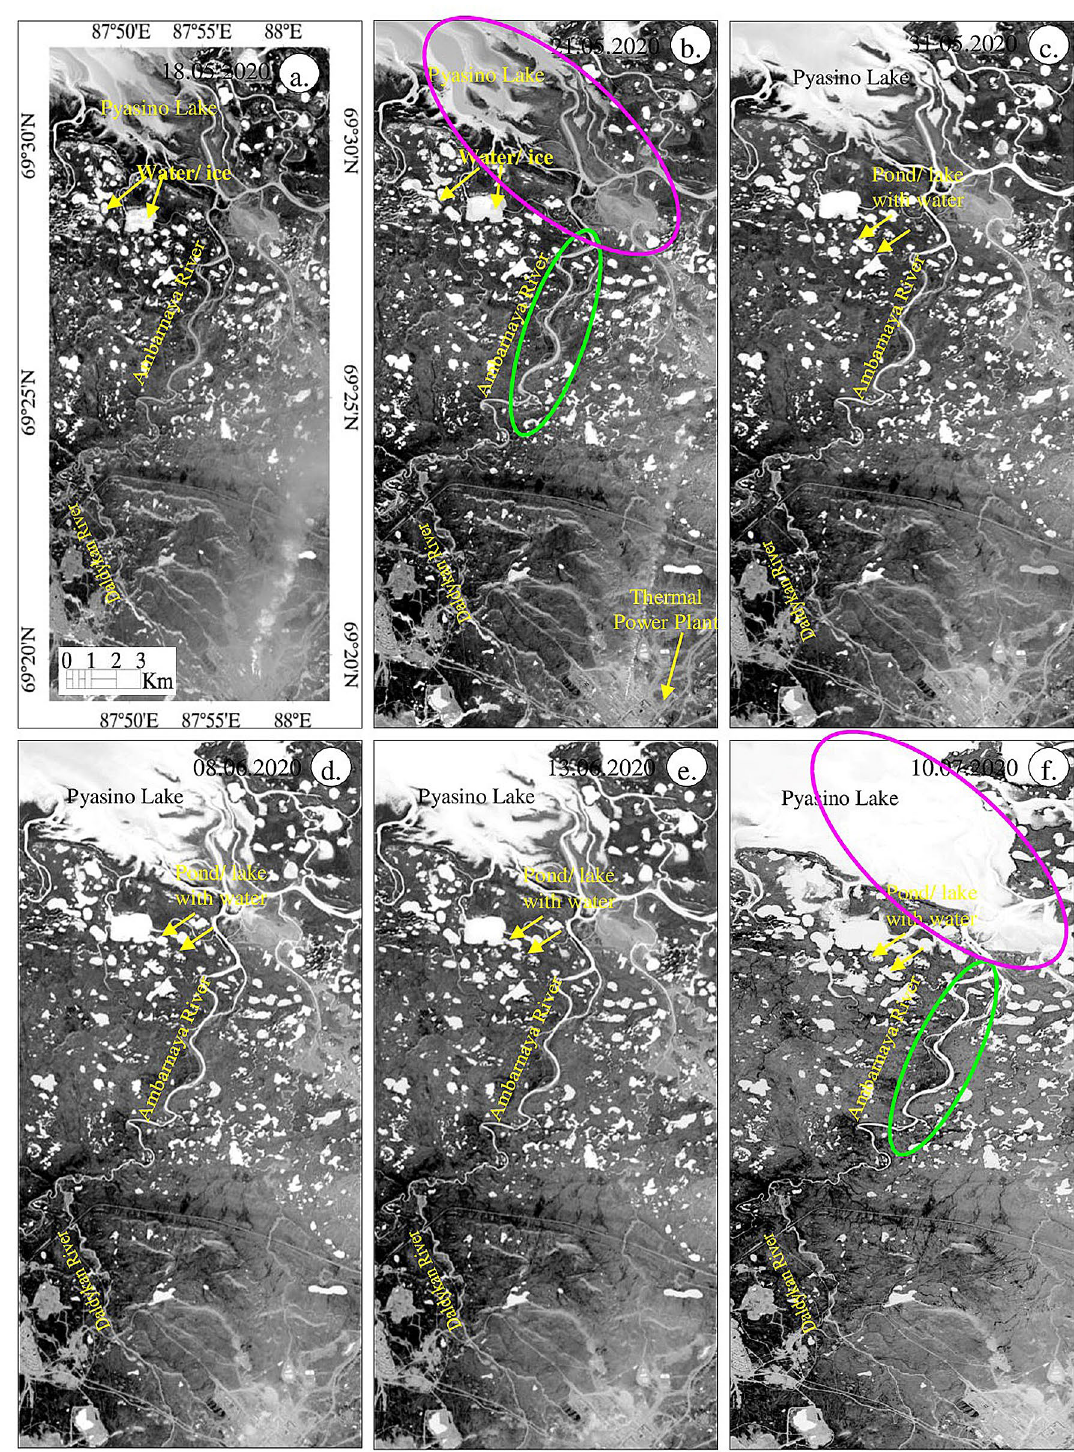
Figure 7. ( a – f ) Sentinel-2 NDWI images of May 18 to July 10, 2020 [ENVI 5.5 https ://www.harri sgeos patia l.com; https ://senti nel.esa.int/] showing the presence of water resources as bright